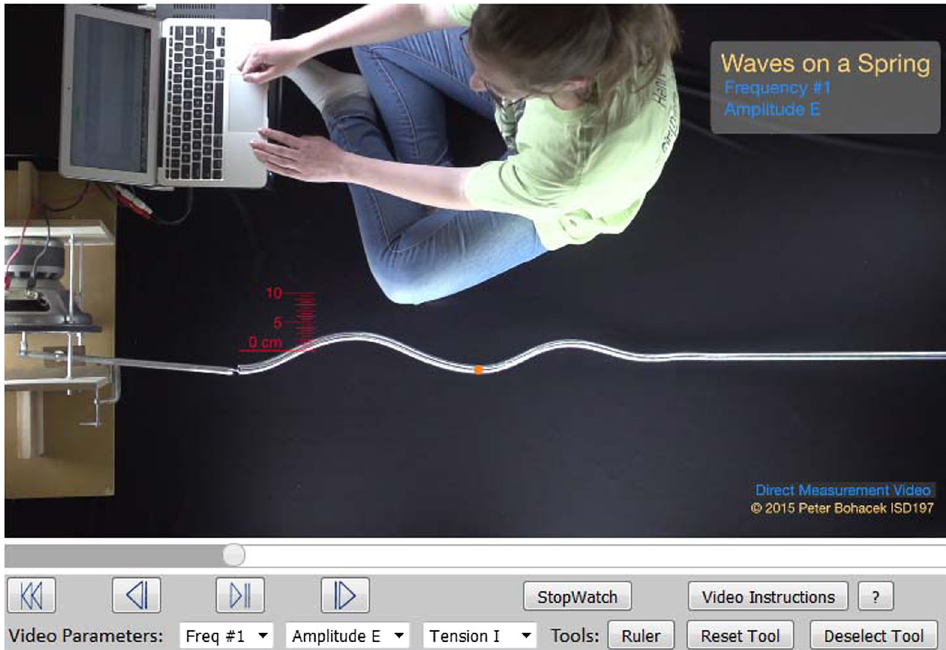
FIG. 1. This video shows a wave moving down a large horizontal spring. Students can access interactive tools by selecting the Ruler and Stop Watch buttons on the bottom toolbar. Using the tools, they can measure the amplitude, frequency, wavelength, period, and speed of the wave. As indicated on the bottom toolbar the current video shows the lowest of five possible frequencies, the largest of five possible amplitudes, and the lowest of three possible tensions. By using the drop-down menus students can select different values for these parameters, which allows them to easily perform a range of experiments. For the model-making assessment (Appendix A), students in classes that had not studied wave phenomena were asked to determine the relationship between the wavelength and frequency of a wave. Successfully completing that task required students to design, execute, and analyze an experiment where the frequency of the wave was varied and the wavelength was measured (while holding the other parameters constant). You may use this online resource for free at the link in Ref.